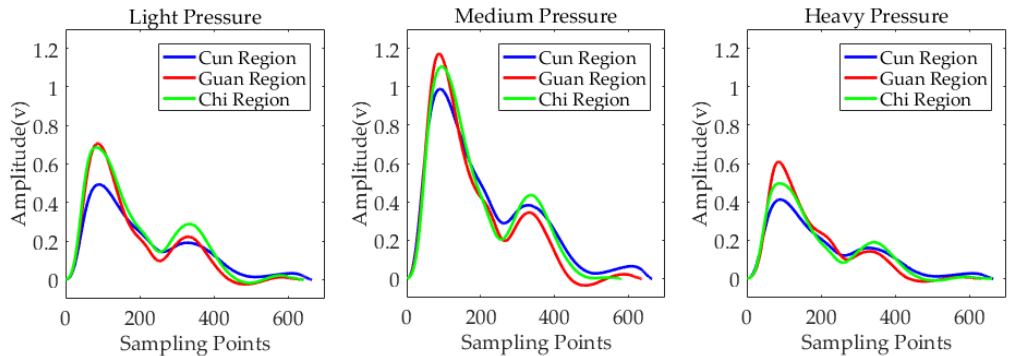
Figure 16. Single period pulse waveforms of three regions under three levels of pressure.